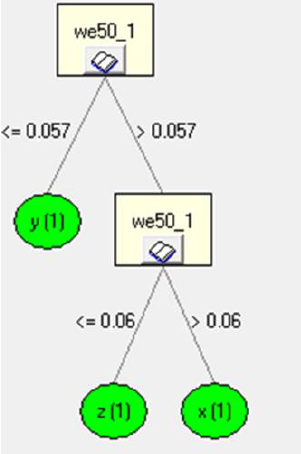
Figure 21. Analysis of the correctness of data classification against the database for the speed of 50 km/h.